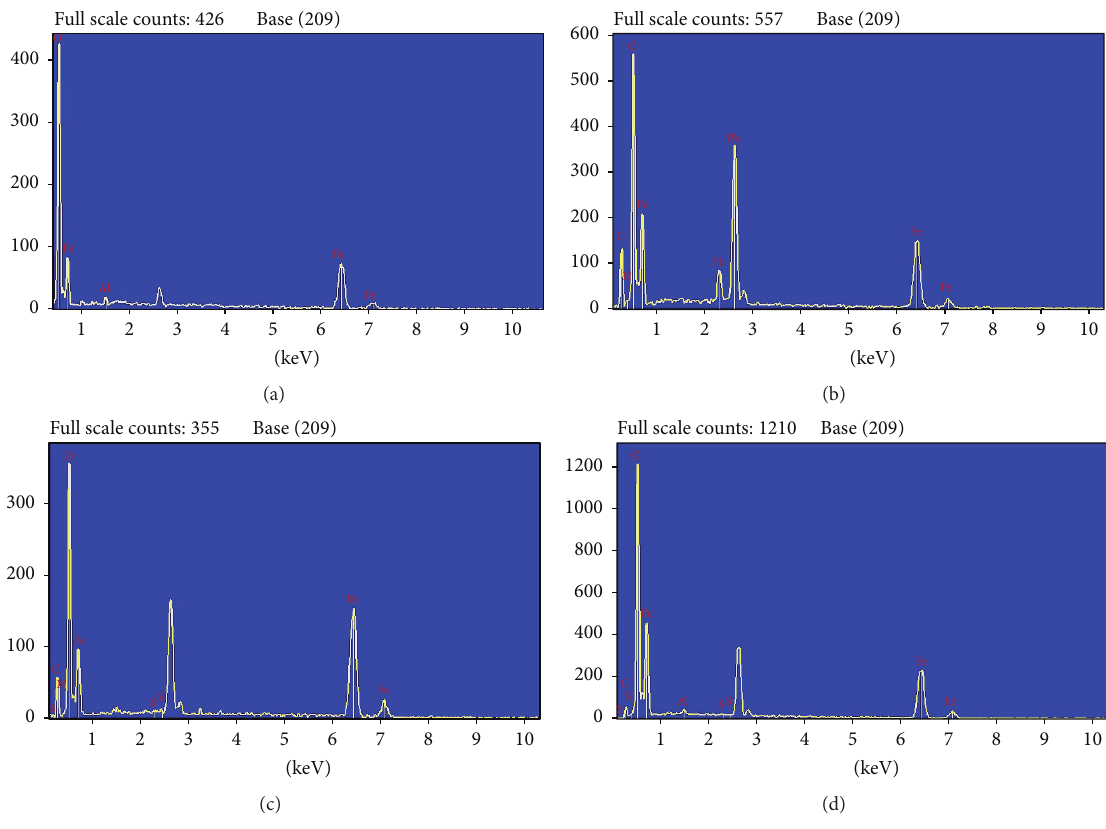
Figure 11: EDX spectra of MS in (a) 0.5 M HCl, (b) 0.88 mM of 2-MTPH, (c) 0.88 mM of 3-MTPH, and (d) 0.88 mM of